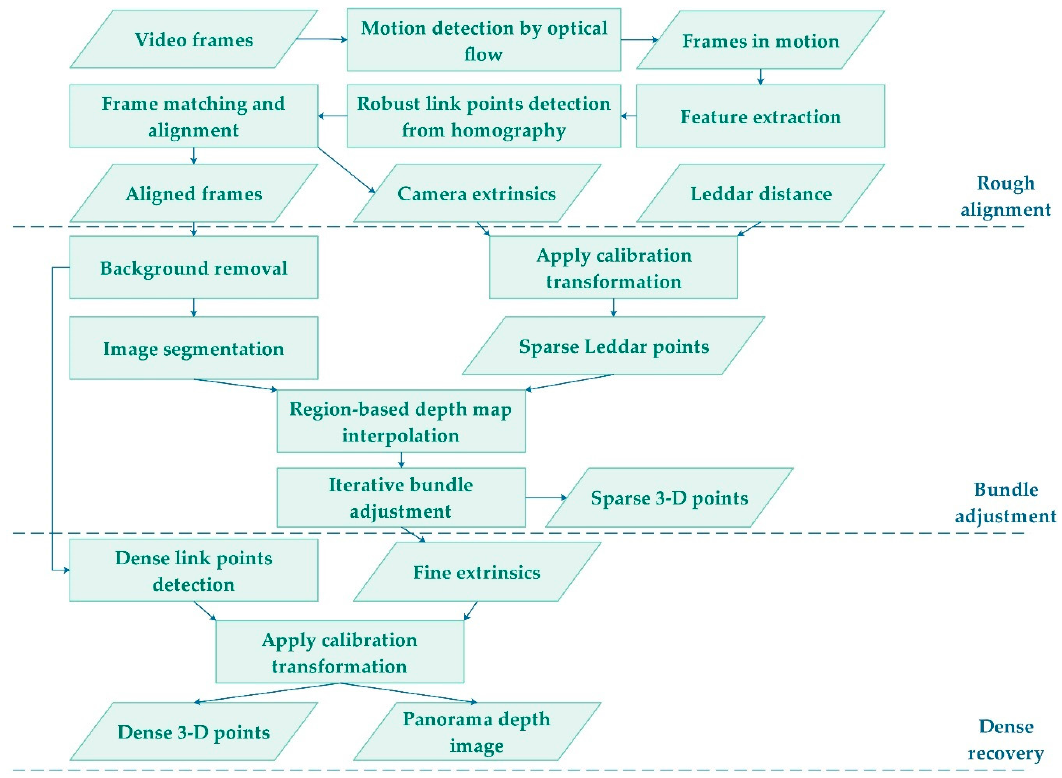
Figure 3. Framework of point cloud recovery from monocular camera and sparse Leddar segments.